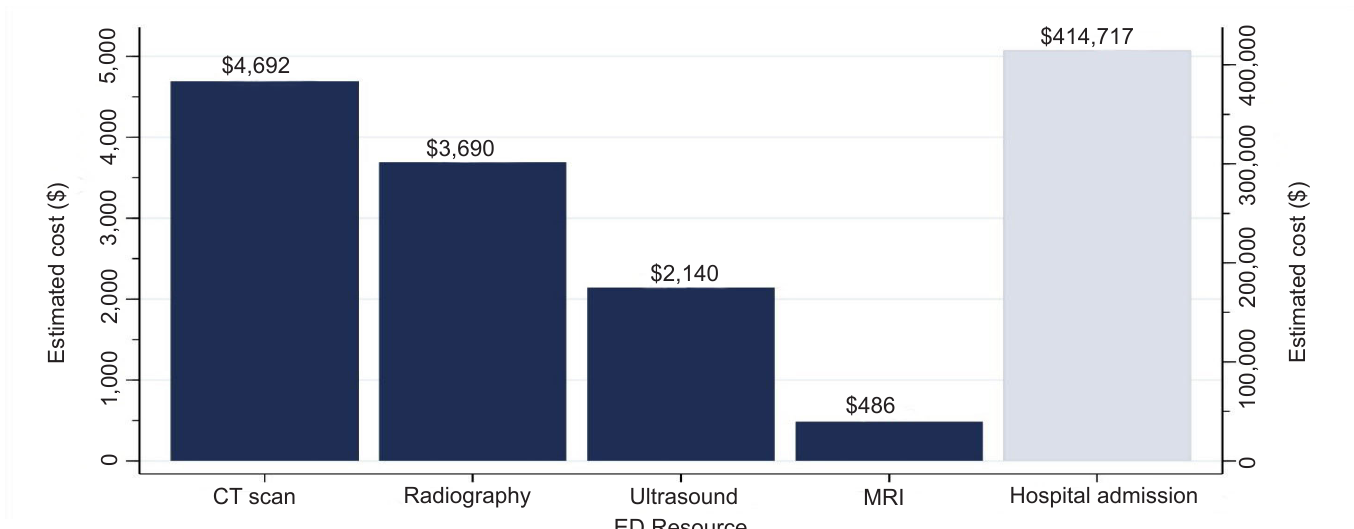
Figure 2. Projected additional costs of emergency departments (ED) with advanced practice providers per 1000 visits, Emergency Department Benchmarking Alliance